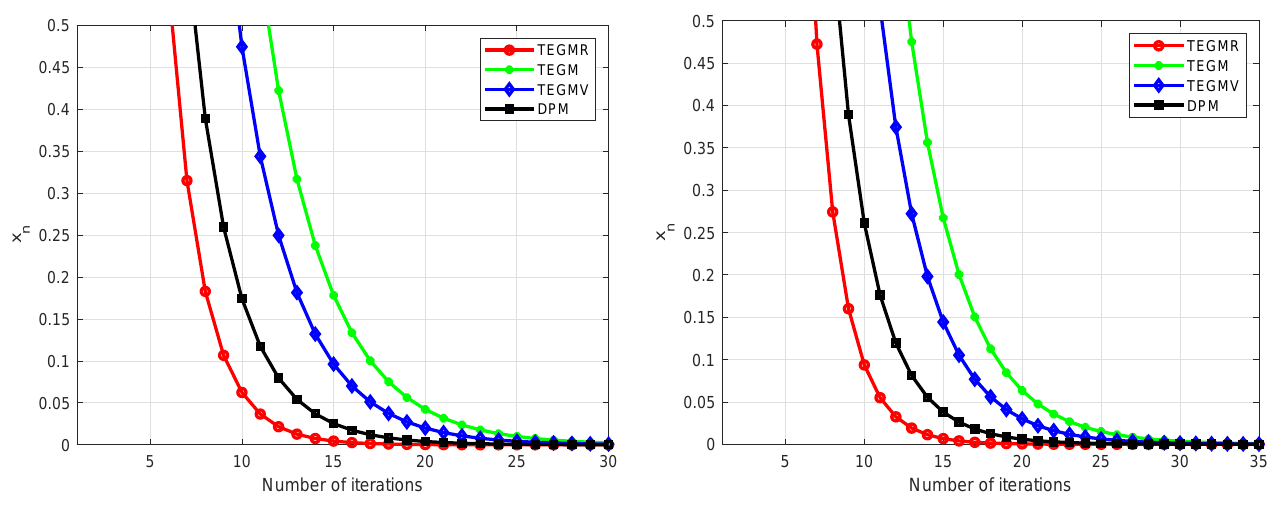
Figure 1. Example 1, left : x 0 = 1; right : x 0 = 5.